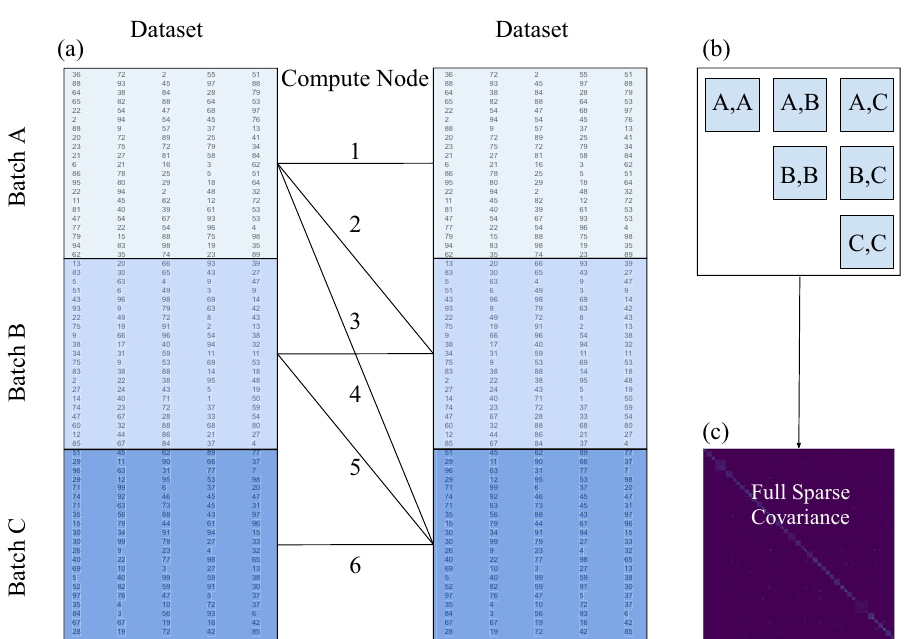
Figure 3. Figure showing a very flexible, non-stationary and compactly-supported kernel function k ( x , y ) (panel a , k s Eq. (10)), and a “sparsified” squared-exponential core kernel k c (panel b ). Only for a one- dimensional input domain, we can visualize the kernel as a function over X set of compactly-supported bump functions to naturally discover sparsity through optimization of the bump functions’ positions, heights, radii, and shapes.Since any multiplication of kernels is a valid kernel, our sparsity- discovering kernel k s (panel a ) can be combined with any kernel; therefore, compared to most approximate methods, it does not limit the user’s ability to design and employ arbitrary kernel functions. Panel ( b ) shows that concept; where the kernel k s has support, the covariance function becomes the squared-exponential kernel.